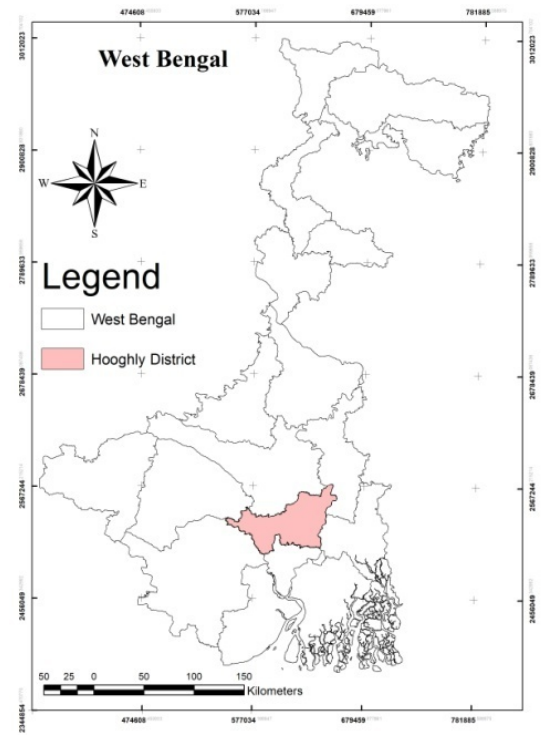
Figure 1. Study area location in West Bengal, India.